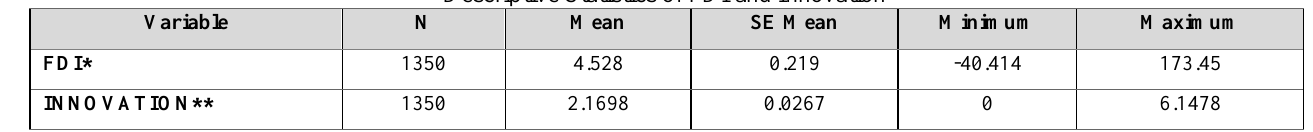
Descriptive Statistics of FDI and